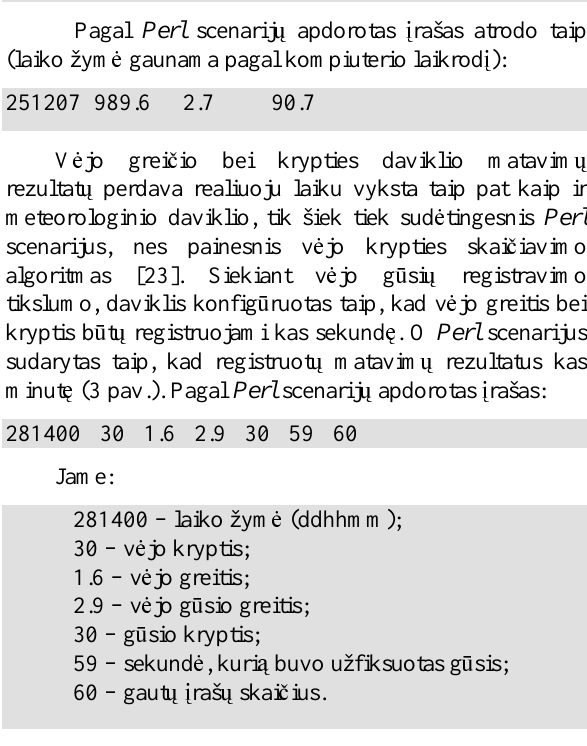
Fig 1 . Scheme of technical equipment and data flow Tokia perdava vyksta pagal special ą parašyt Perl programavimo kalba (2 pav.).